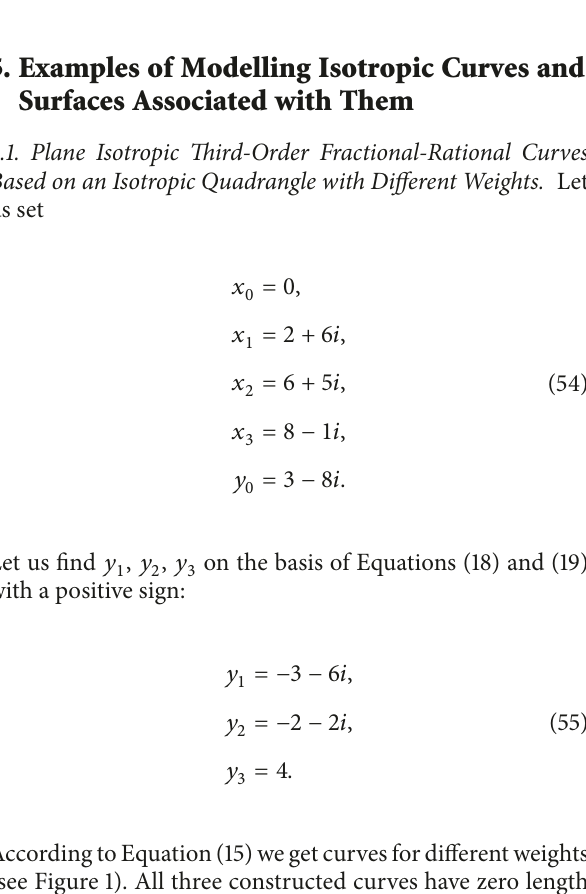
Figure 1: Cubic fractional-rational curves with different weights. Solid line – for 𝑤 0 = 1 , 𝑤 1 = 8 , 𝑤 2 = 1 , 𝑤 3 = 1 , dotted line – 𝑤 = 1 , 𝑤 = 1 , 𝑤 = 8 , 𝑤 = 1 , dash-dotted line – 𝑤 0 1 2 3 𝑤 = 2 , 𝑤 = 1 . The reference points are indicated by circles and 2 3 connected by a broken